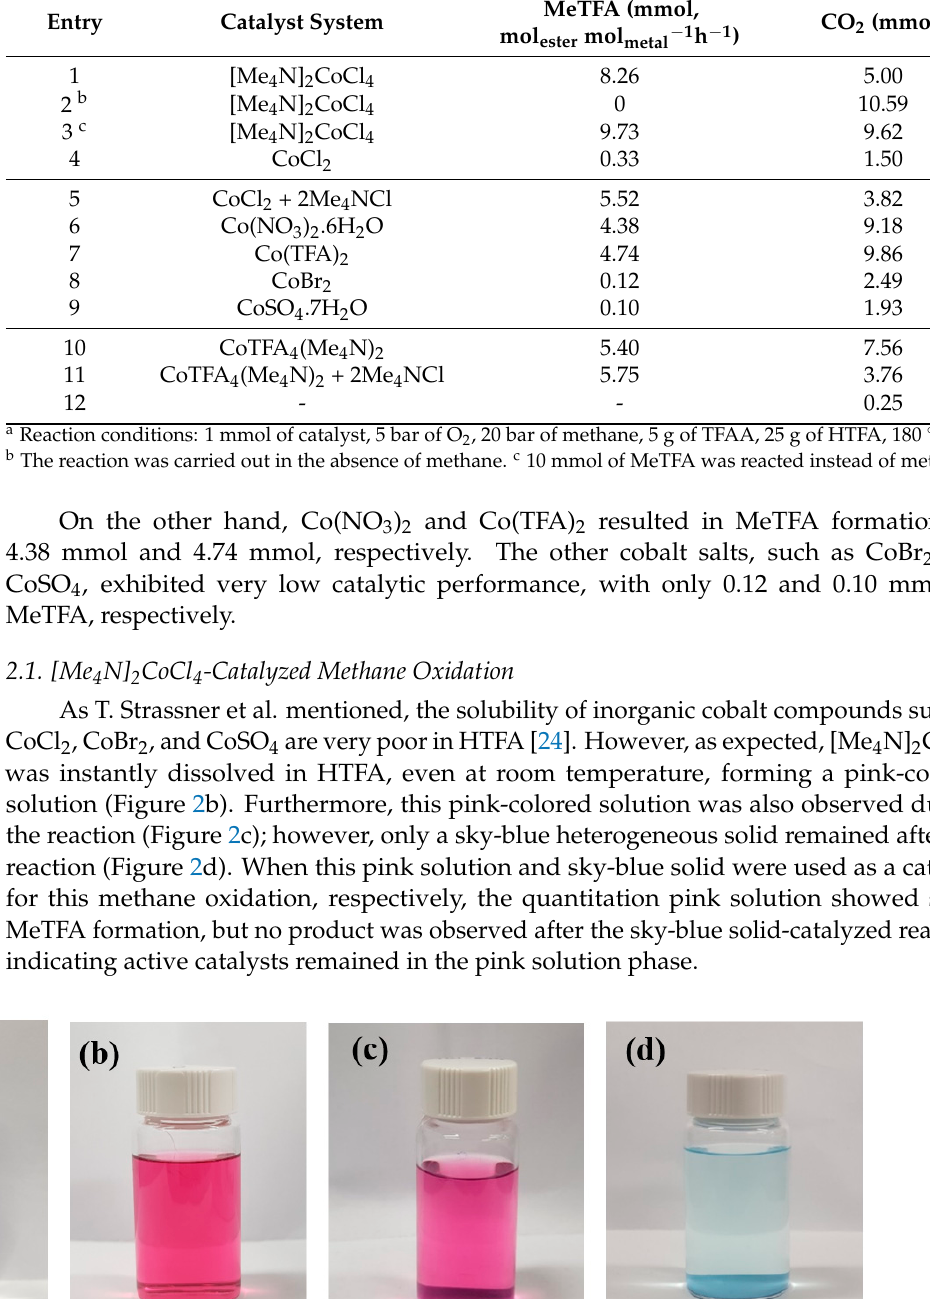
Table 1. Aerobic methane oxidation using various Co catalysts a .